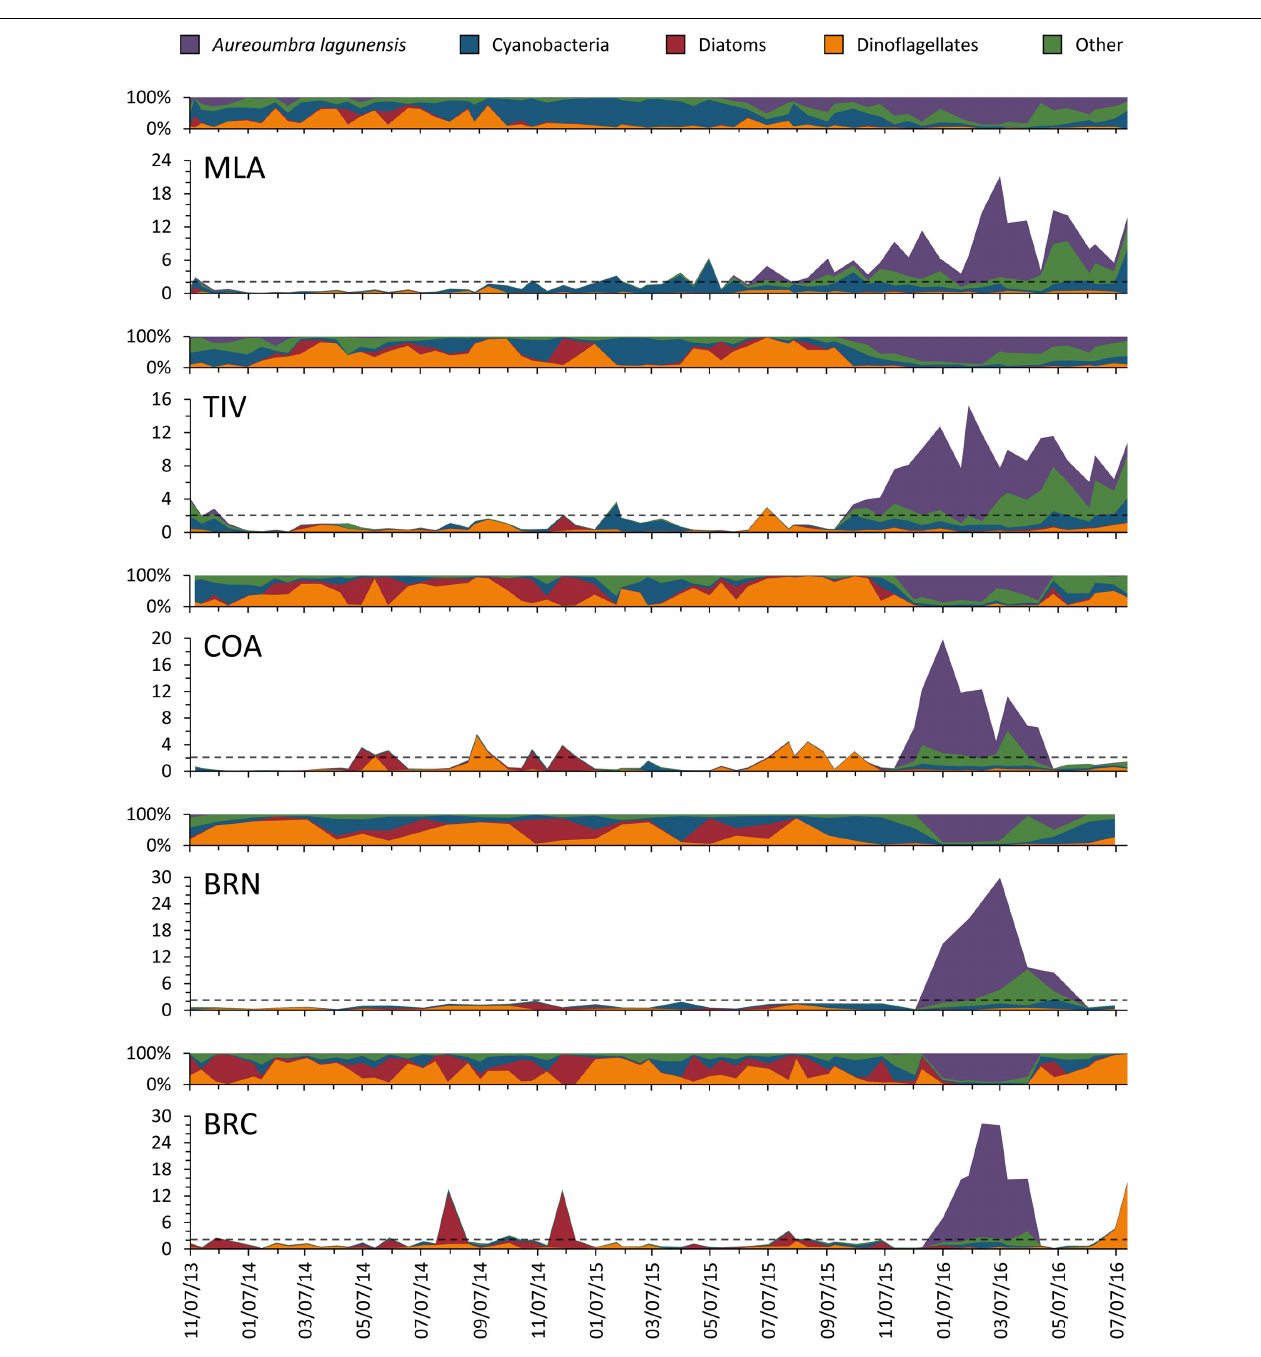
FIGURE 2 | For each of the five mesozooplankton sampling sites, relative percentages (top) and biomasses ( µ g C mL − 1 , bottom) of all five phytoplankton categories monitored during the study. The gray dashed lines denote the 2 µ g C mL − 1 bloom threshold.